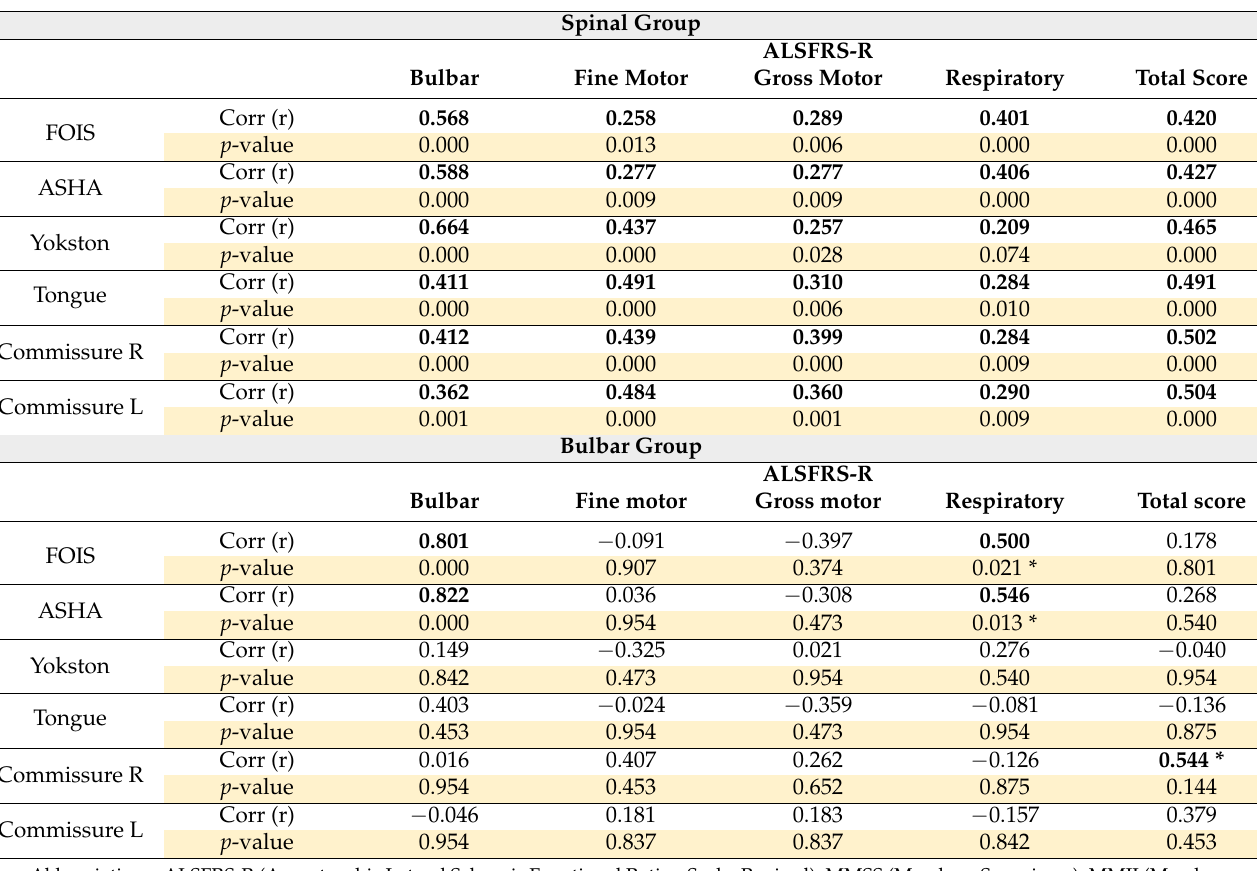
Table 4. Spearman’s correlation coefficients between speech-language clinical findings and the total score of the ALSFRS-R and its subscale scores for the diagnostic